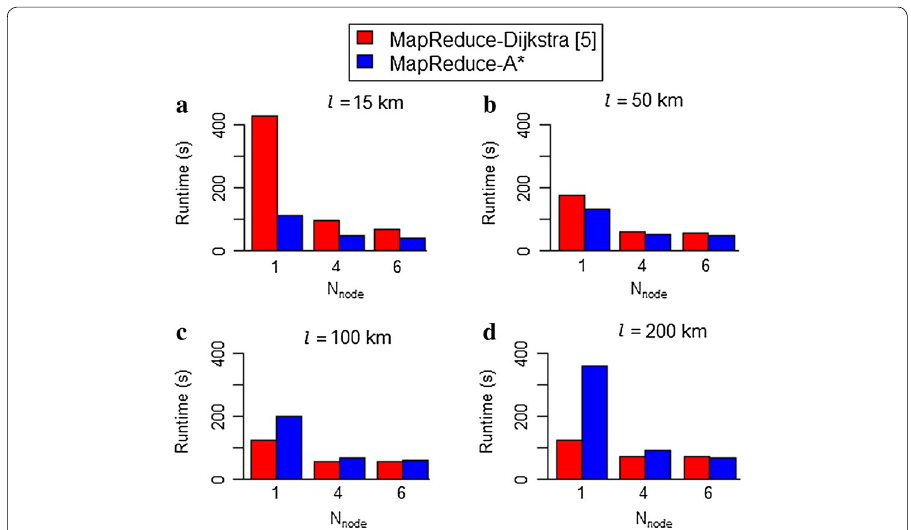
Fig. 14 Comparison of the computational time of MapReduce-Dijkstra [6] and